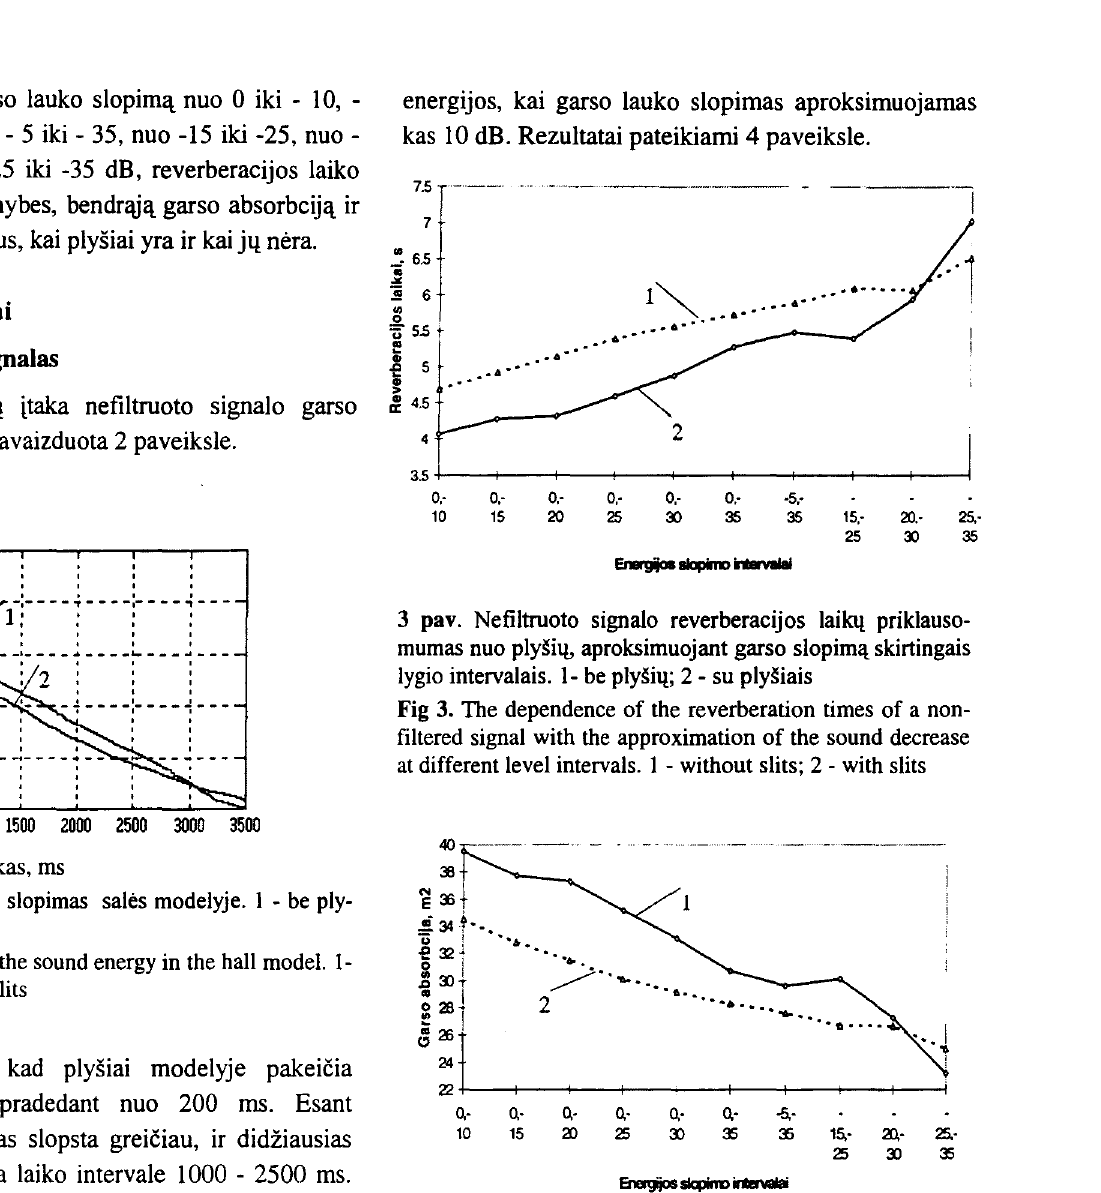
Fig 2. The decrease of the sound energy in the hall model. ! without slits; 2 - with slits Tyrimai rodo, kad plysiai modelyje pakeicia energijos slopim~ pradedant nuo 200 ms. Esant